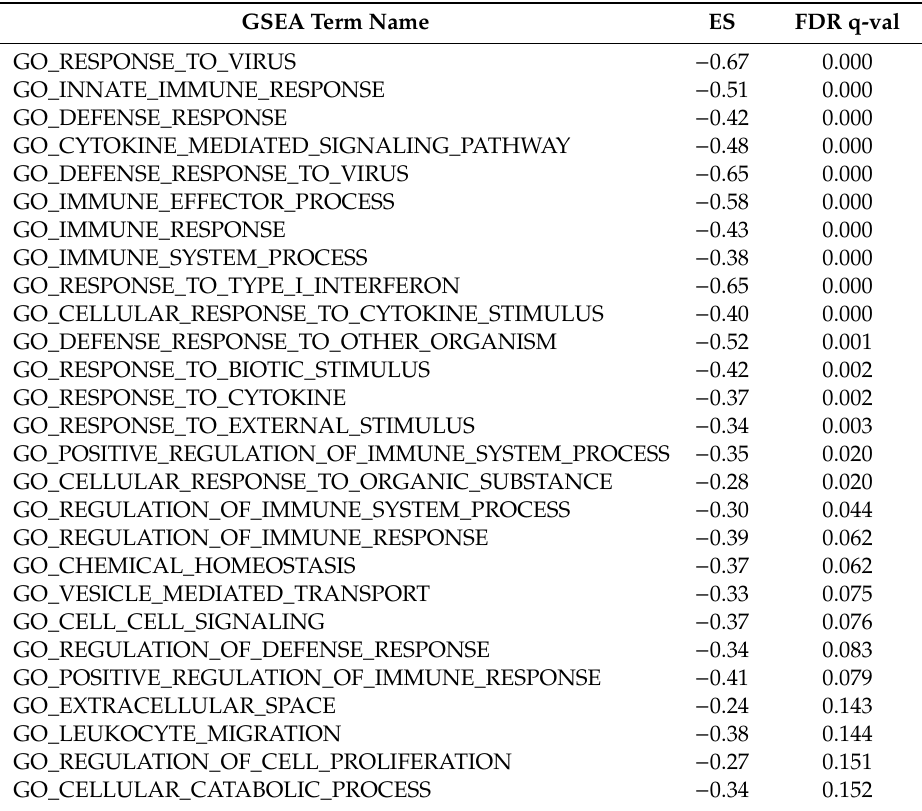
Table 3. Downregulated gene sets (GSEA) of PBMCs treated with the DL-PCB mixture.